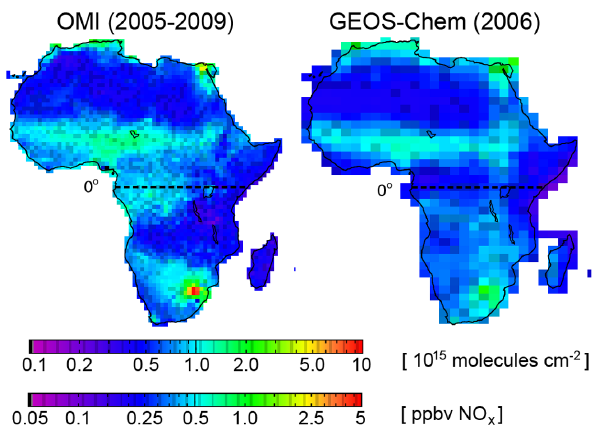
Fig. 7. Annual mean tropospheric NO 2 columns over Africa at 12:00–15:00LT. The left panel shows OMI 2005–2009 data at 1 × 1 ◦ resolution (Boersma et al., 2007). The right panel shows GEOS-Chem model values for 2006. The colorbar includes bound- ary layer ( < 1km) NO x estimated from column NO 2 (see text for details). Biomass burning influence was removed using MODIS fire counts and OMI smoke AAOD in the observations, and black car- bon AOD in GEOS-Chem. The equator is indicated.